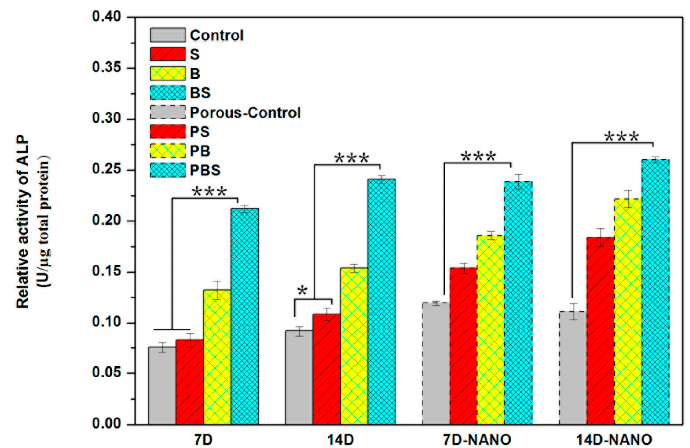
Figure 8. Alkaline phosphatase (ALP) expression of MC3T3-E1 cells on different surface structures after seven-day and 14-day cultures.